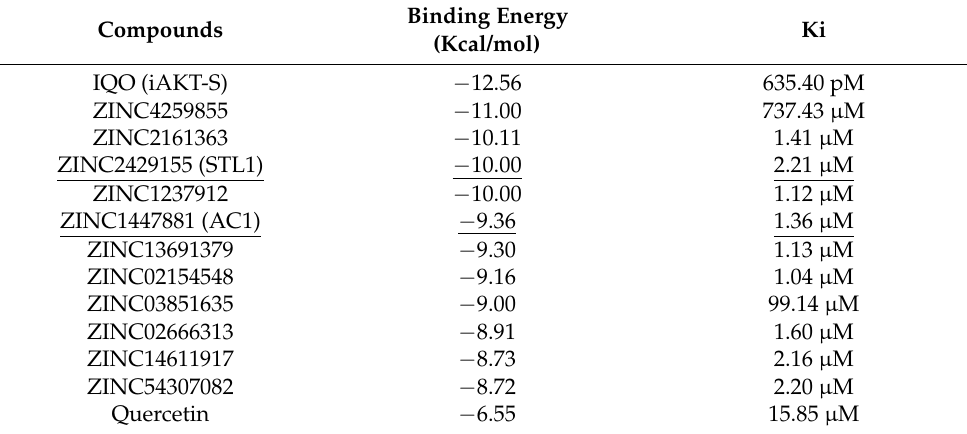
Table 1. Results of molecular docking simulations. The IQO compound is a known inhibitor of AKT1 and has been used as a positive control. Quercetin does not interact with AKT1 and has been employed as a negative control.